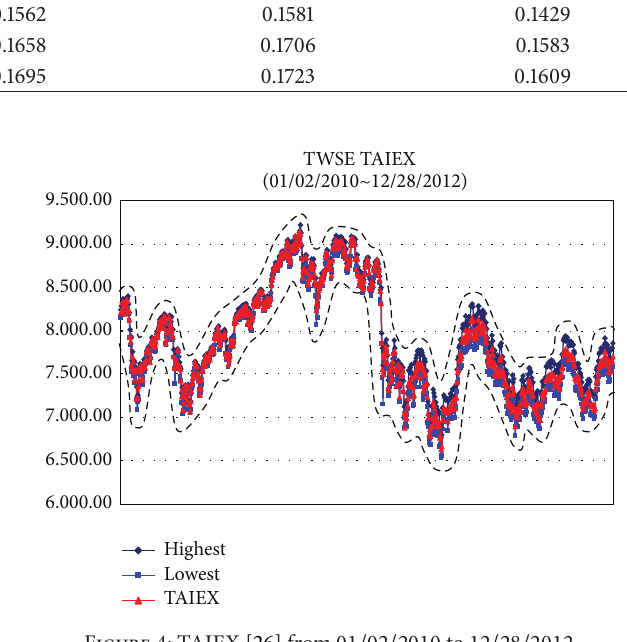
Figure 4: TAIEX [26] from 01/02/2010 to 12/28/2012 .